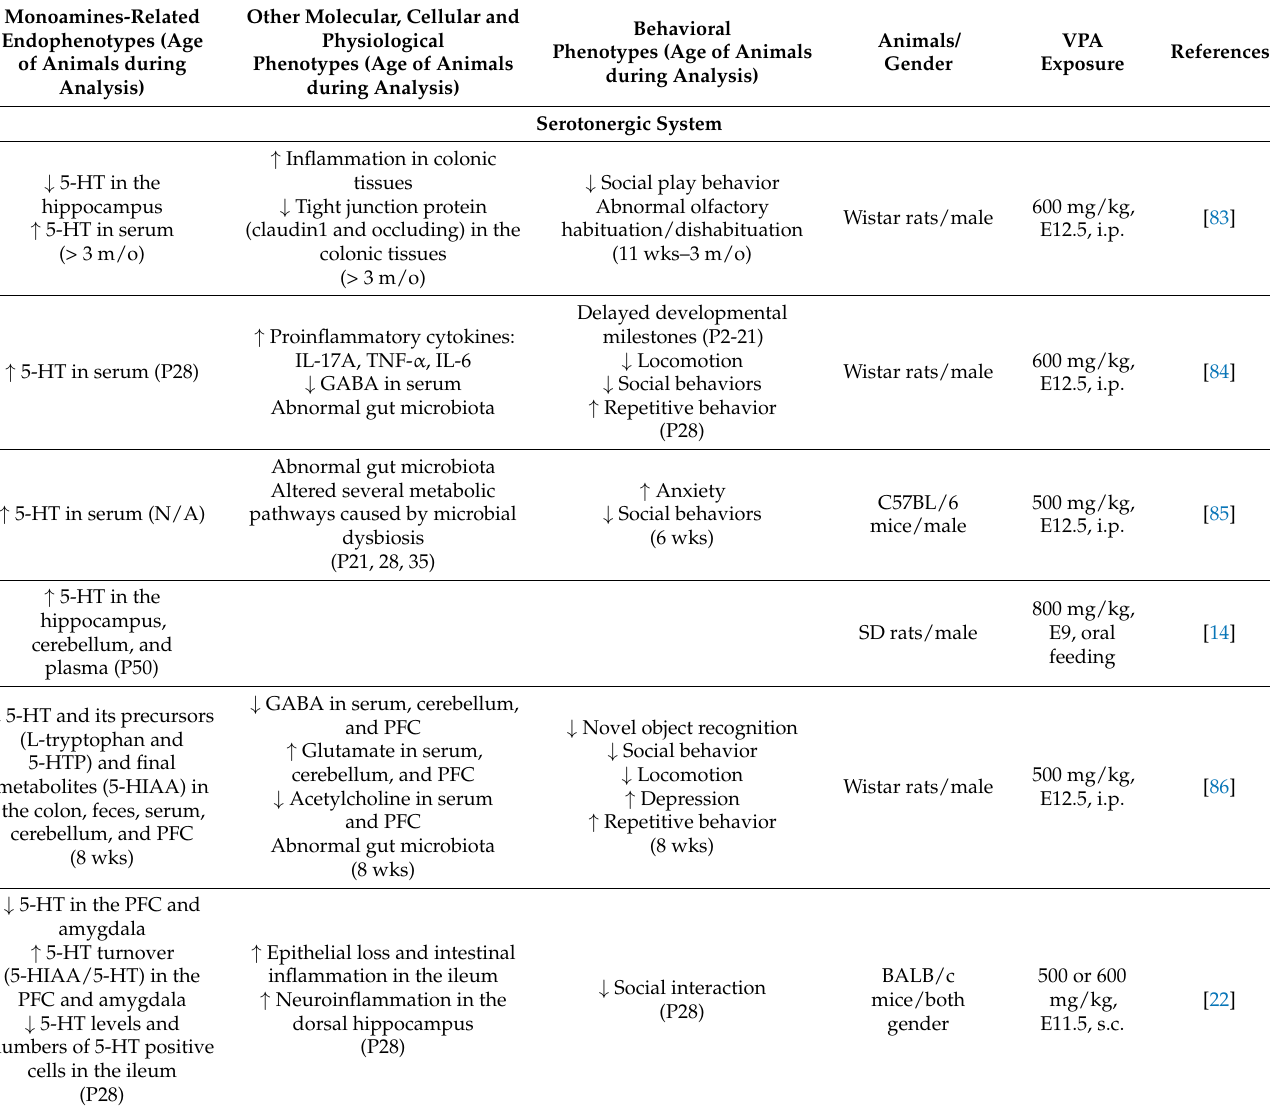
Table 1. Summary of valproic acid (VPA)-induced teratogenicity in serotonergic